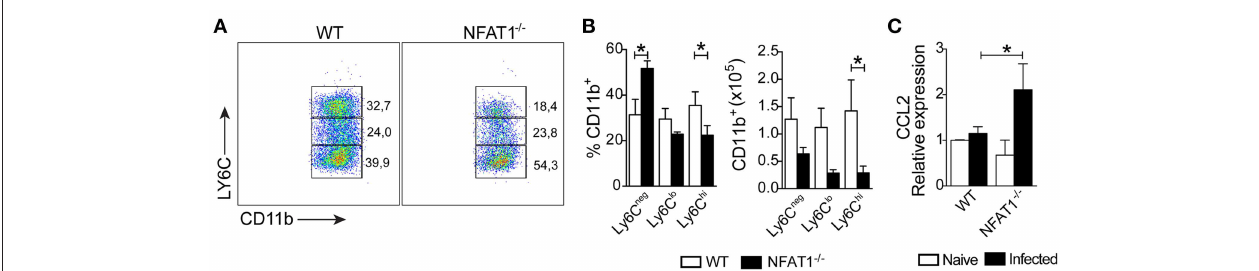
FIGURE 3 | Lack of NFAT1 inhibits LY6C hi monocyte migration to CNS. The mononuclear cells were isolated from the CNS of WT and NFAT1 − / − mice at day 25 post-infection with 100 cysts of the ME-49 strain of T. gondii . The myeloid cells (CD11b + CD45 hi ) were analyzed by the expression of Ly6C hi , LY6C lo , and Ly6C neg by flow cytometry (A) . The frequency and the absolute number of the monocyte subsets are shown (B) . The relative expression of CCL2 mRNA in the CNS from WT and NFAT1 − / − mice was evaluated at 25 dpi by qPCR (C) . The data shown are representative of the mean ± SEM of five mice per experimental group of two independent experiments (* P < 0.05).